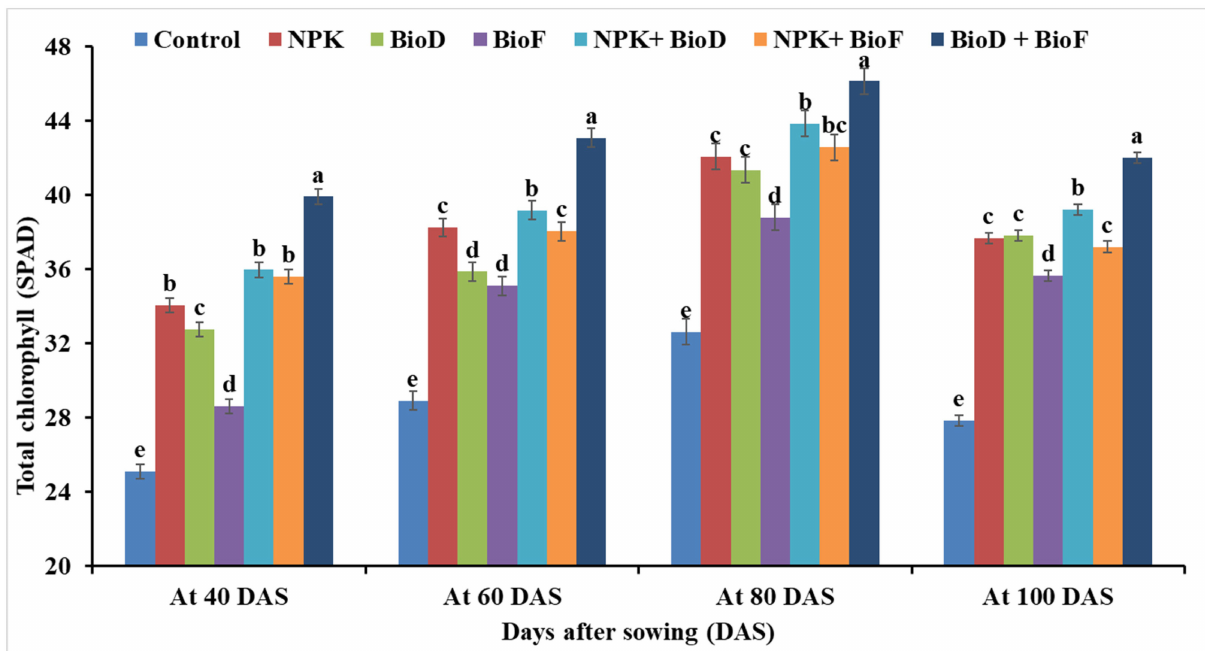
Figure 1. Effect of synthetic, organic, and bio-fertilizers on total chlorophyll content (SPAD) of faba bean. Columns with different letters significantly differed from each other as indicated by the Tukey test ( p ≤ 0.05).